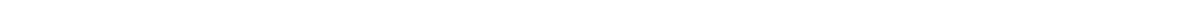
Figure 6 | Ectopic expression of Lpg1137 blocks autophagosome formation. ( a ) HeLa-Fc g RII cells were transfected with a plasmid encoding GFP, GFP-Lpg1137 wild-type (WT) or GFP-Lpg1137 S68A. At 24h after transfection, cells were incubated with EBSS (SV: left two columns) or EBSS plus 0.1 m M bafilomycin A1 (SV þ bafilomycin A1, right two columns) for 2h. After incubation, cells were fixed and stained with an anti-LC3 antibody. The bar graphs on the right show the ratio of the LC3 staining intensity of GFP-expressing to that of -nonexpressing cells. Values are means ± s.d. ( n ¼ 3). ** P o 0.001 as compared with GFP-Lgp1137 S68A. Scale bar, 5 m m. ( b ) HeLa-Fc g RII cells were transfected with a plasmid encoding GFP or GFP-Lpg1137. At 24h after transfection, cells were incubated with EBSS (SV) ± 0.1 m M bafilomycin A1 (Baf) for 2h and then lysed. Equal amounts of the lysates were analysed by IB with the indicated antibodies. ( c ) HeLa-Fc g RII cells expressing FLAG-DFCP1 (left two columns) or 3 (cid:2) -FLAG-Atg14L (right two columns) were transfected with a plasmid encoding GFP, GFP-Lpg1137 WTor GFP-Lpg1137 S68A. At 24h after transfection, cells were incubated with EBSS for 2h, fixed and then stained with an anti-FALG antibody. The bar graphs shown at the bottom exhibit the ratio of the FLAG-DFCP1 or 3 (cid:2) -FLAG-Atg14L staining intensity of GFP-expressing to that of -nonexpressing cells (50 cells each). Values are means ± s.d. ( n ¼ 3). ** P o 0.001 as compared with GFP-Lpg1137 S68A. Scale bar, 5 m m. ( d ) HeLa-Fc g RII cells were transfected without (Mock) or with siRNA targeting Stx17 (Stx17 knockdown (KD)). At 48h after transfection, cells were transfected with a plasmid encoding FLAG-DFCP1 or 3 (cid:2) -FLAG-Atg14L, incubated for 24h and then with EBSS for 2h. The cells were fixed and stained with an anti-FLAG antibody. Scale bar, 5 m m. Uncropped images of blots are shown in Supplementary Fig.